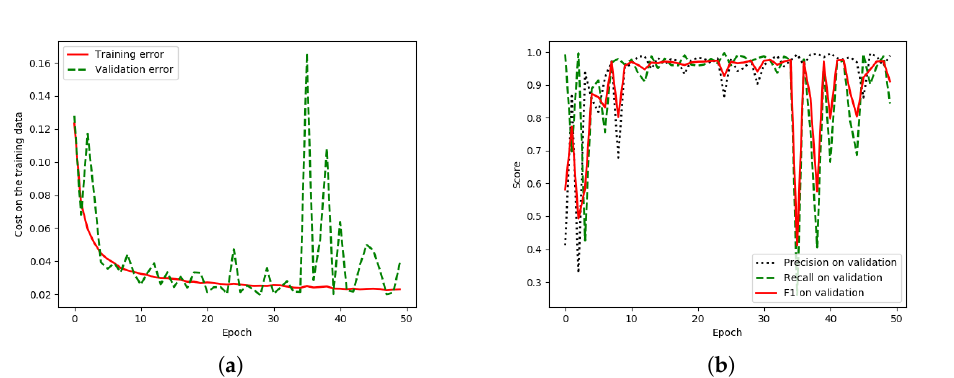
Figure 13. Graph (learning curves) of the Landsat-8w3c data set of the baseline approach, GCN152-TL-A; x refers to epochs, and y refers to different measures ( a ) Plot of model loss (cross-entropy) on training and validation corpora; ( b ) performance plot on the validation corpus.